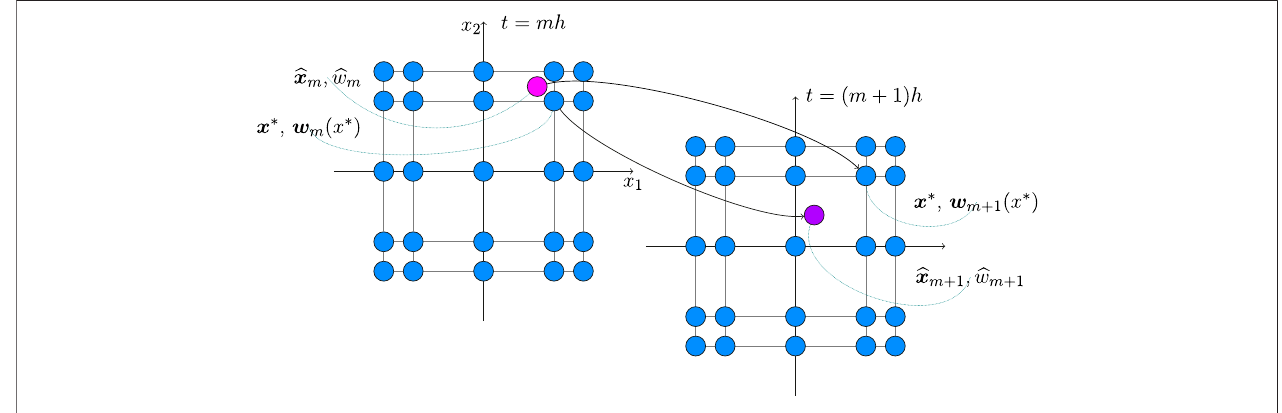
FIGURE 1 | Evolution of the spatial variable and the corresponding PDF for two consecutive time steps related to the fi xed Chebyshev grid in the case of two